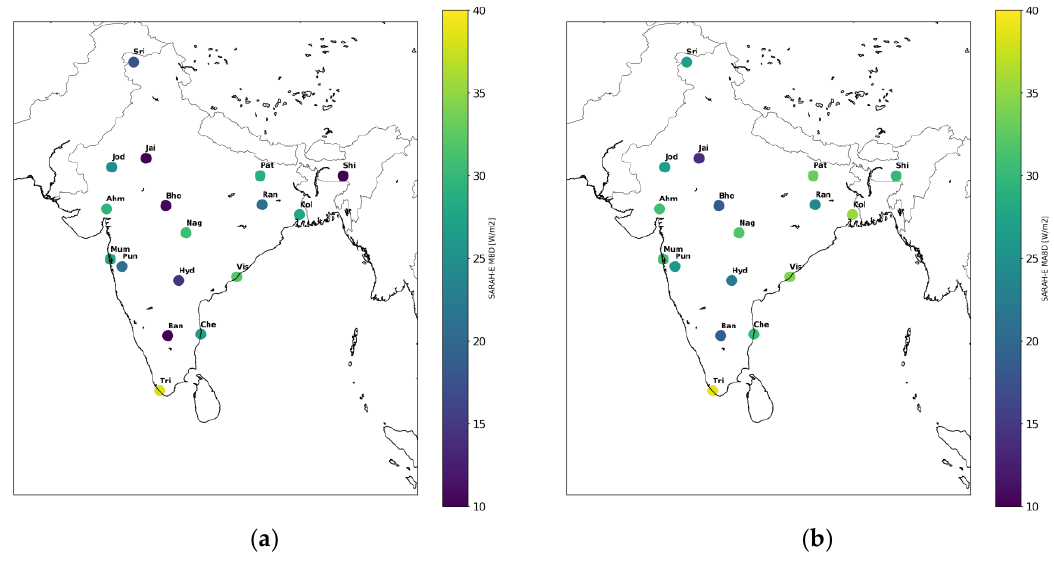
Figure 2. Geographical distribution across the validation sites of: ( a ) SARAH-E MBD; and ( b ) SARAH-E RMSD.